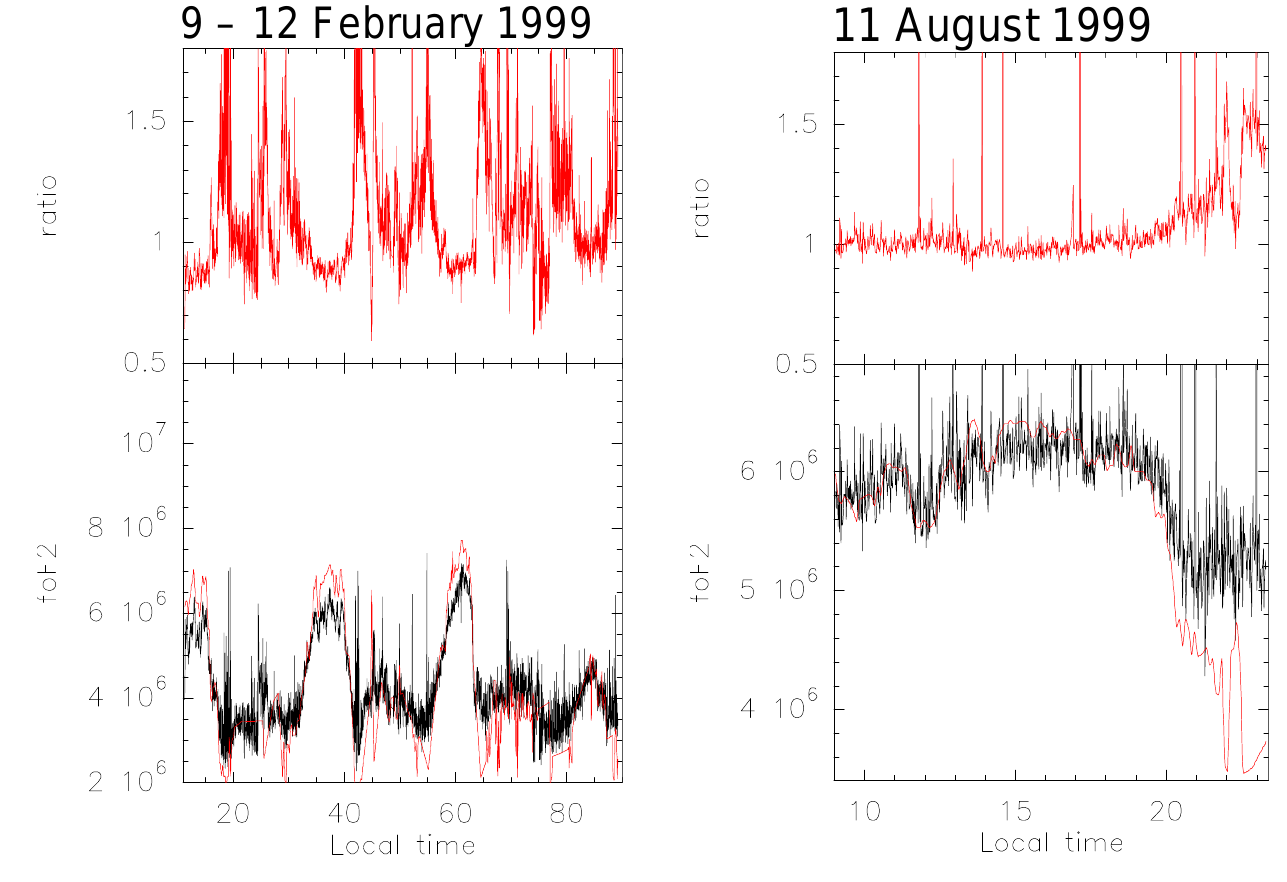
Fig. 5. fo F2 comparison between the IS radar data in black and the Dynasonde.